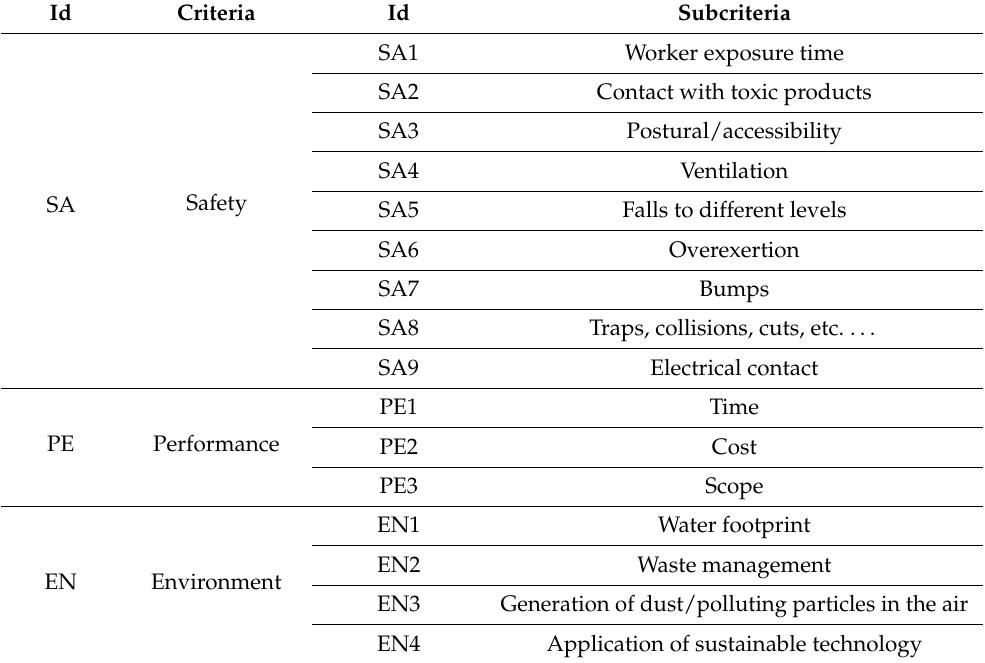
Table 2. Identification of criteria and